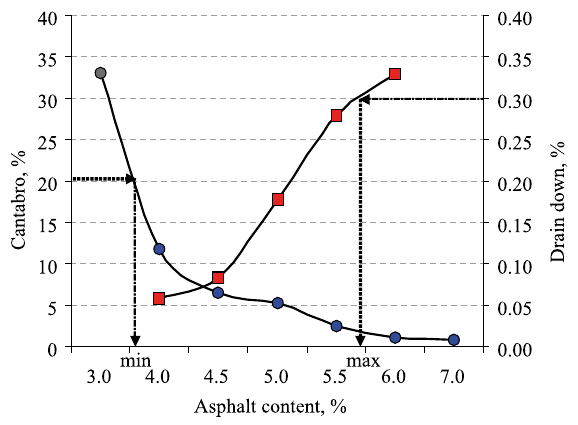
Fig. 5. Determination of max and min allowable asphalt content for the porous asphalt